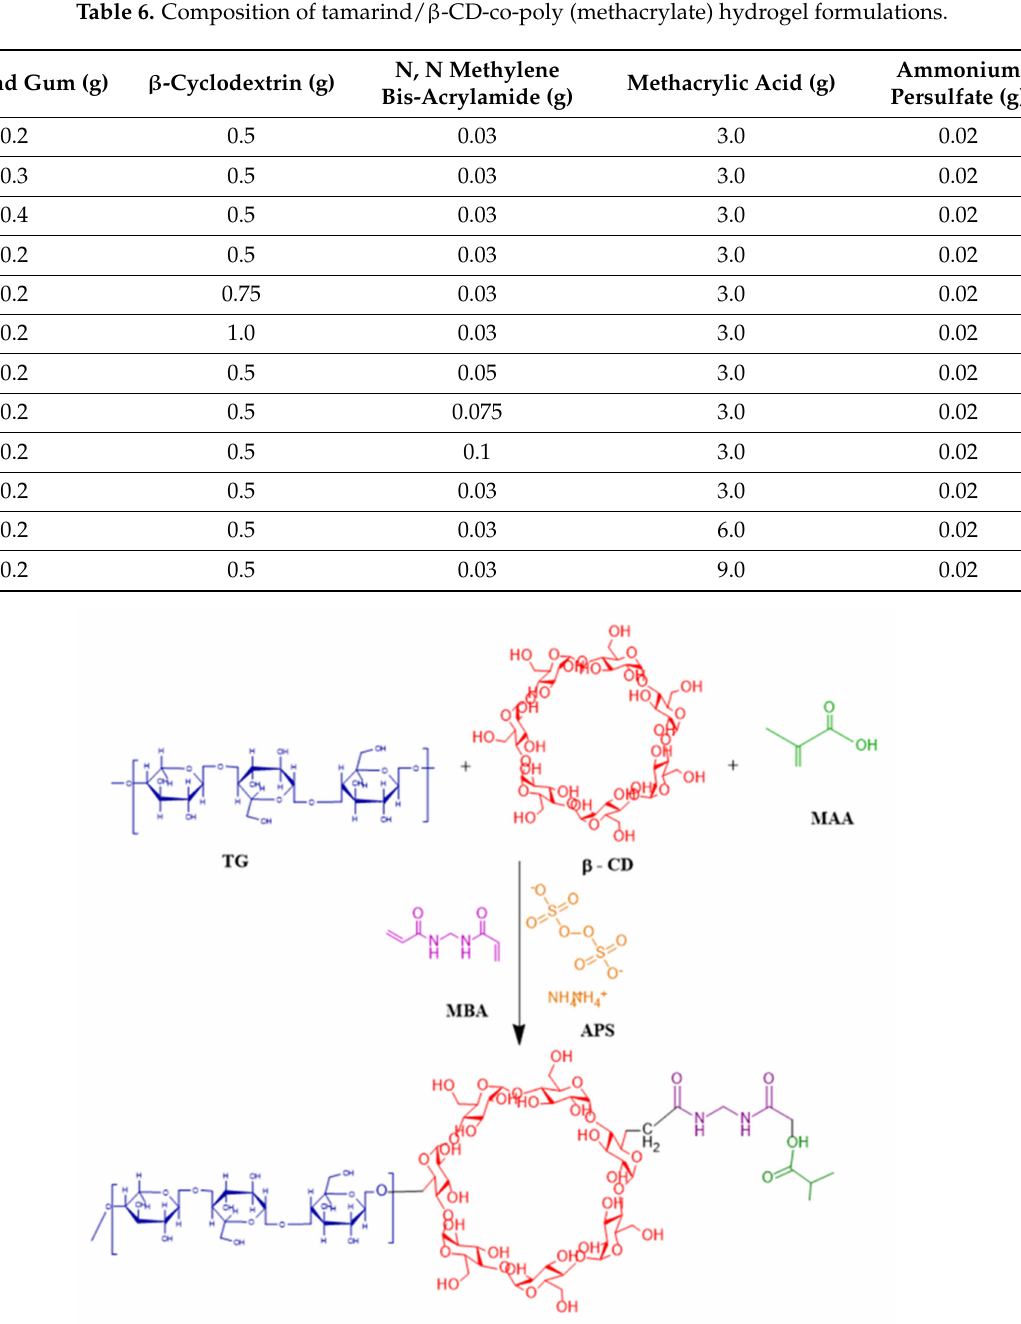
Figure 14. Proposed chemical structure of tamarind- β -CD-co-poly (methacrylate)